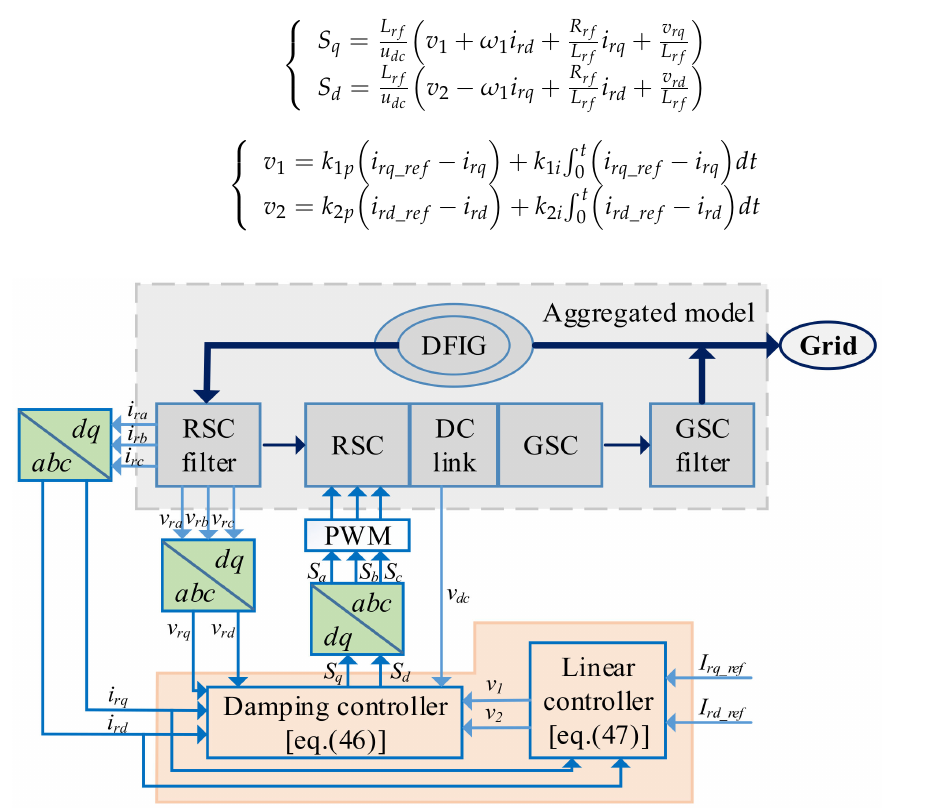
Figure 11. Implementation block diagram of the damping controller using partial feedback lineariza- tion